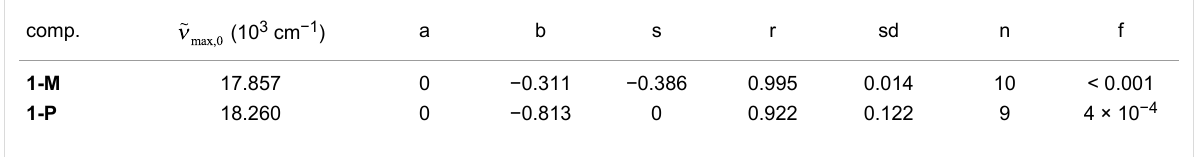
Table 3: Solvent-independent correlation coefficients a, b and s of the Kamlet–Taft parameters α , β and π * ; solute property of the reference system , correlation coefficient (r), standard deviation (sd), number of solvents (n) and significance (f) for the solvatochromism of 1-M and 1-P .